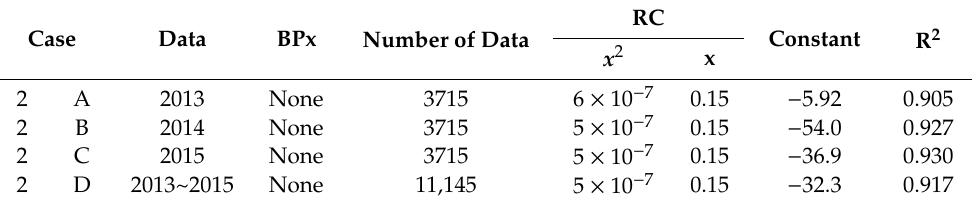
Table 6. Quadratic regression analysis result.